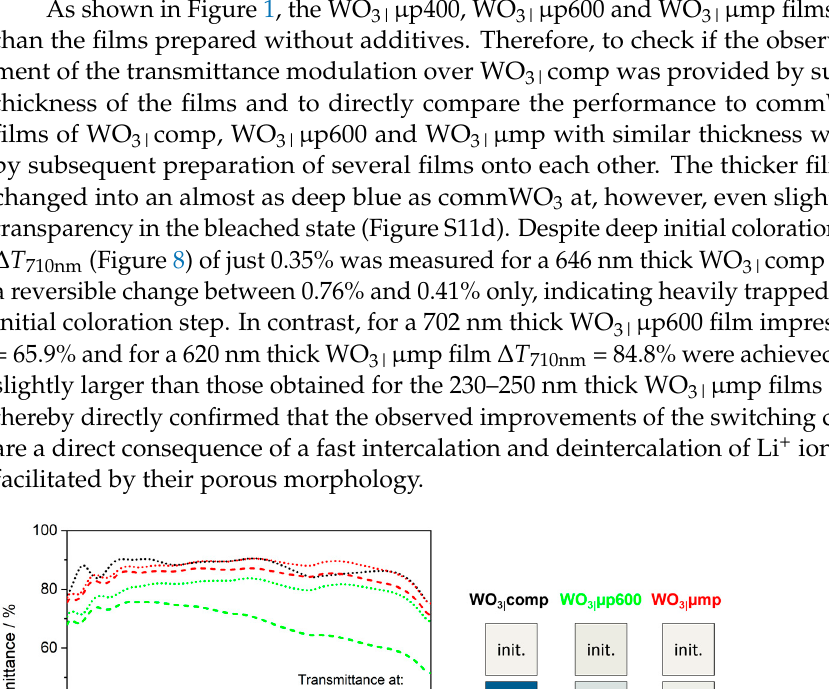
Figure 9. Optical transmittance at 710 nm of ( a ) WO 3| comp and ( b ) WO 3| µmp in LiClO 4 in PC, rec- orded during chronoamperometry between the potentials depicted as dashed profiles. The insets show the calculated color impressions of the films at the first and the third cycle at the colored states.